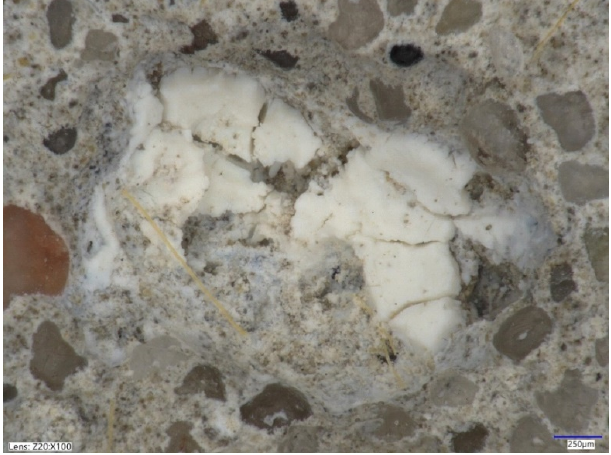
Figure 5. Micrograph of crystallized TiO 2 on the surface of the photocatalytic mortar.